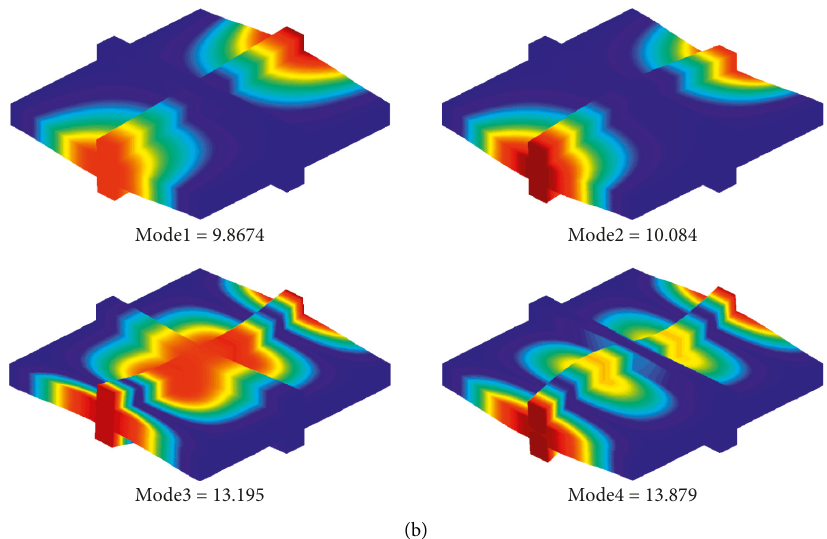
Figure 9: Some mode shapes of multi-stepped FG-CNTRC plate. (a) CCCC. (b) CCFF.